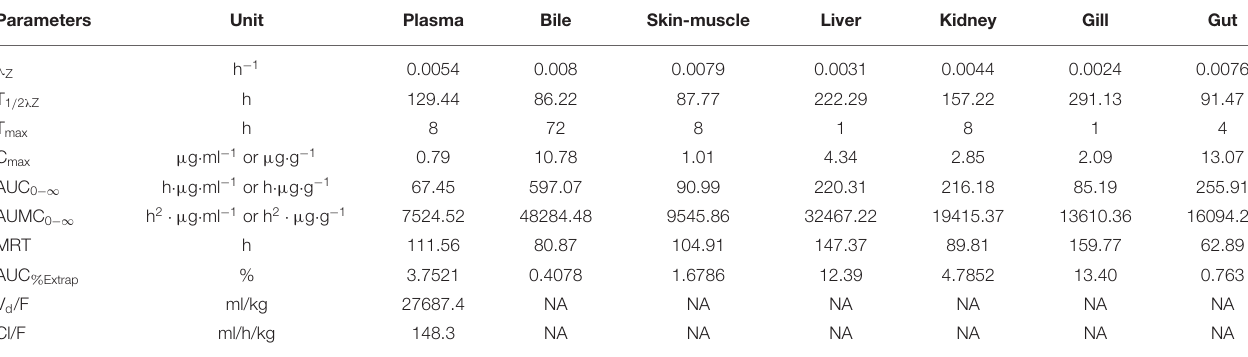
TABLE 2 | Pharmacokinetics parameters of enrofloxacin in plasma, bile, and different tissues of Yellow River carp ( Cyprinus carpio haematoperus ) after oral administration of single-dose (10 mg/kg BW) at 20 ◦ C. Parameters Unit Plasma Bile